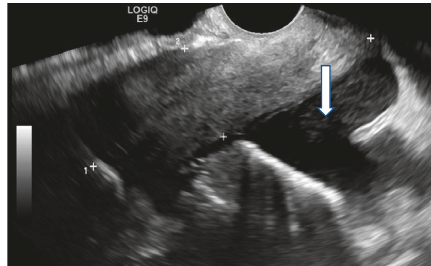
Figure 1: Complex free fluid.